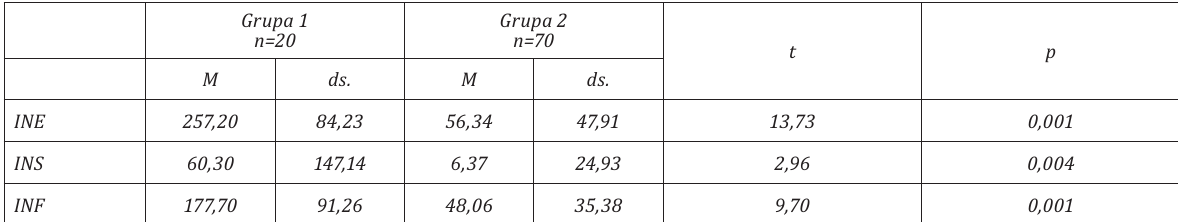
Tabela 1. Średnie indeksy nadużycia emocjonalnego (INE), seksualnego (INS) i fizycznego (INF) w wyodrębnionych grupach osób z zespołem uzależnienia od alkoholu